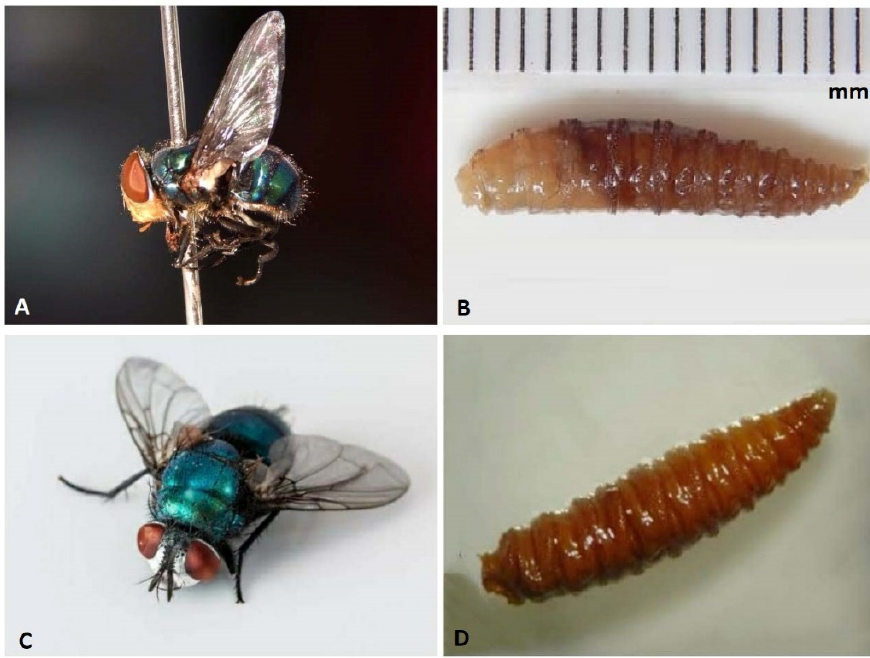
Figure 2. (A) Latrine fly Chrysomya megacephala , (B) Third instar larva of C. megacephala extracted from vagina, (C) Old world screwworm Chrysomya bezziana , (D) Third instar larva of C. bezziana extracted from vagina